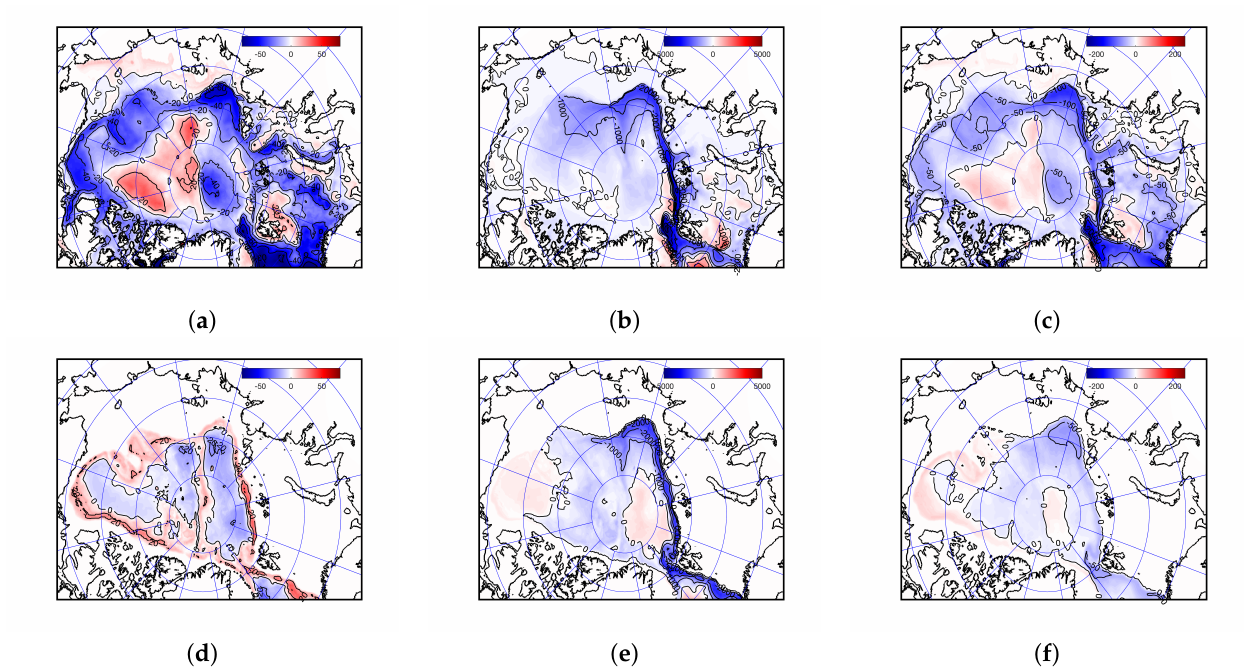
Figure 14. Annually averaged deviations in ( a , d ) mass of water (kg/m 2 ), ( b , e ) its heat content (MJ/m 2 ), and ( c , f ) mass of salt (kg/m 2 ) per square meter of the Arctic area (above 65 N), obtained as a result of vertical integration from 30 to 600 m depth ( a – c ) and from 600 m to the ocean floor in terms of incremental values in numerical experiment B to experiment A.